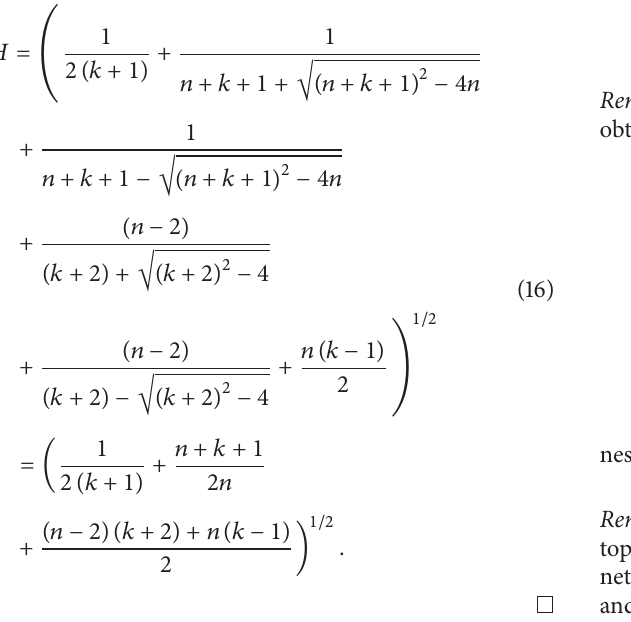
Figure 14: The variance of 𝐻 2 norm for 𝑆 𝑛−1 ∘ 𝑃 3 ( 𝑛 ≥ 3